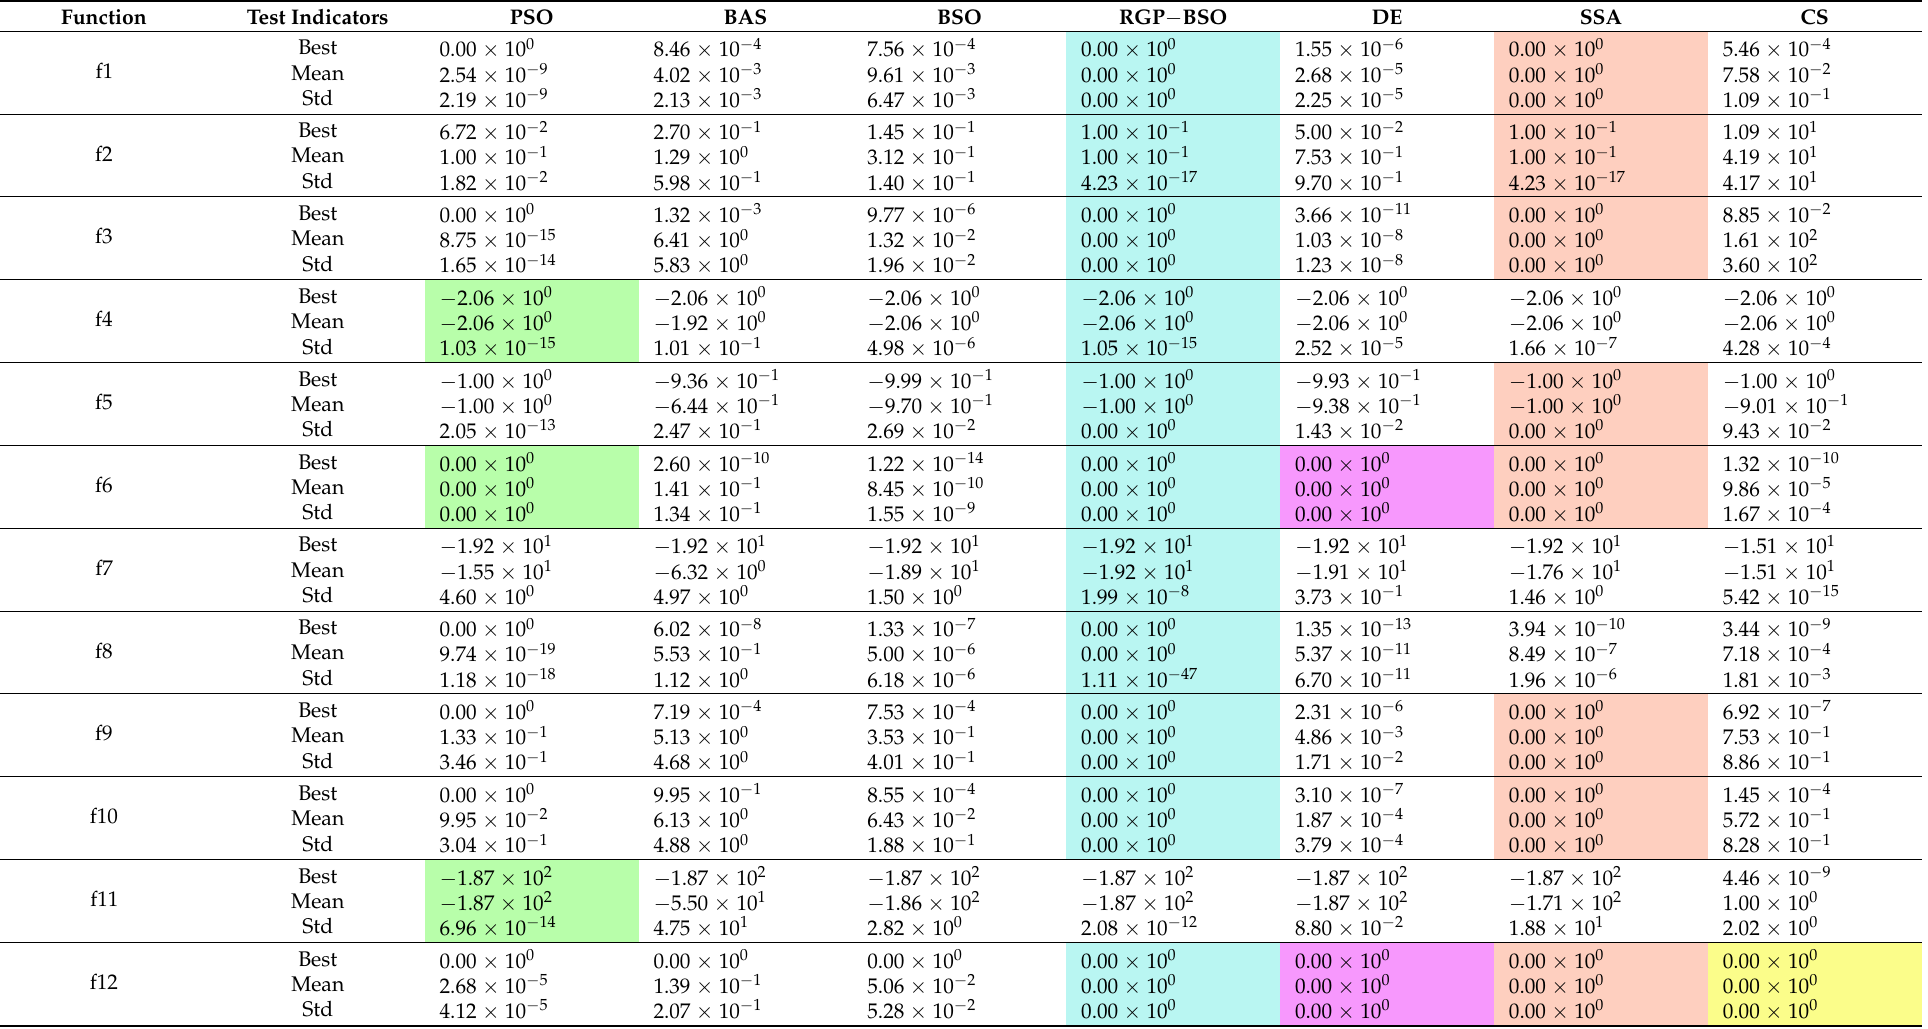
Table 2. Algorithm optimization performance